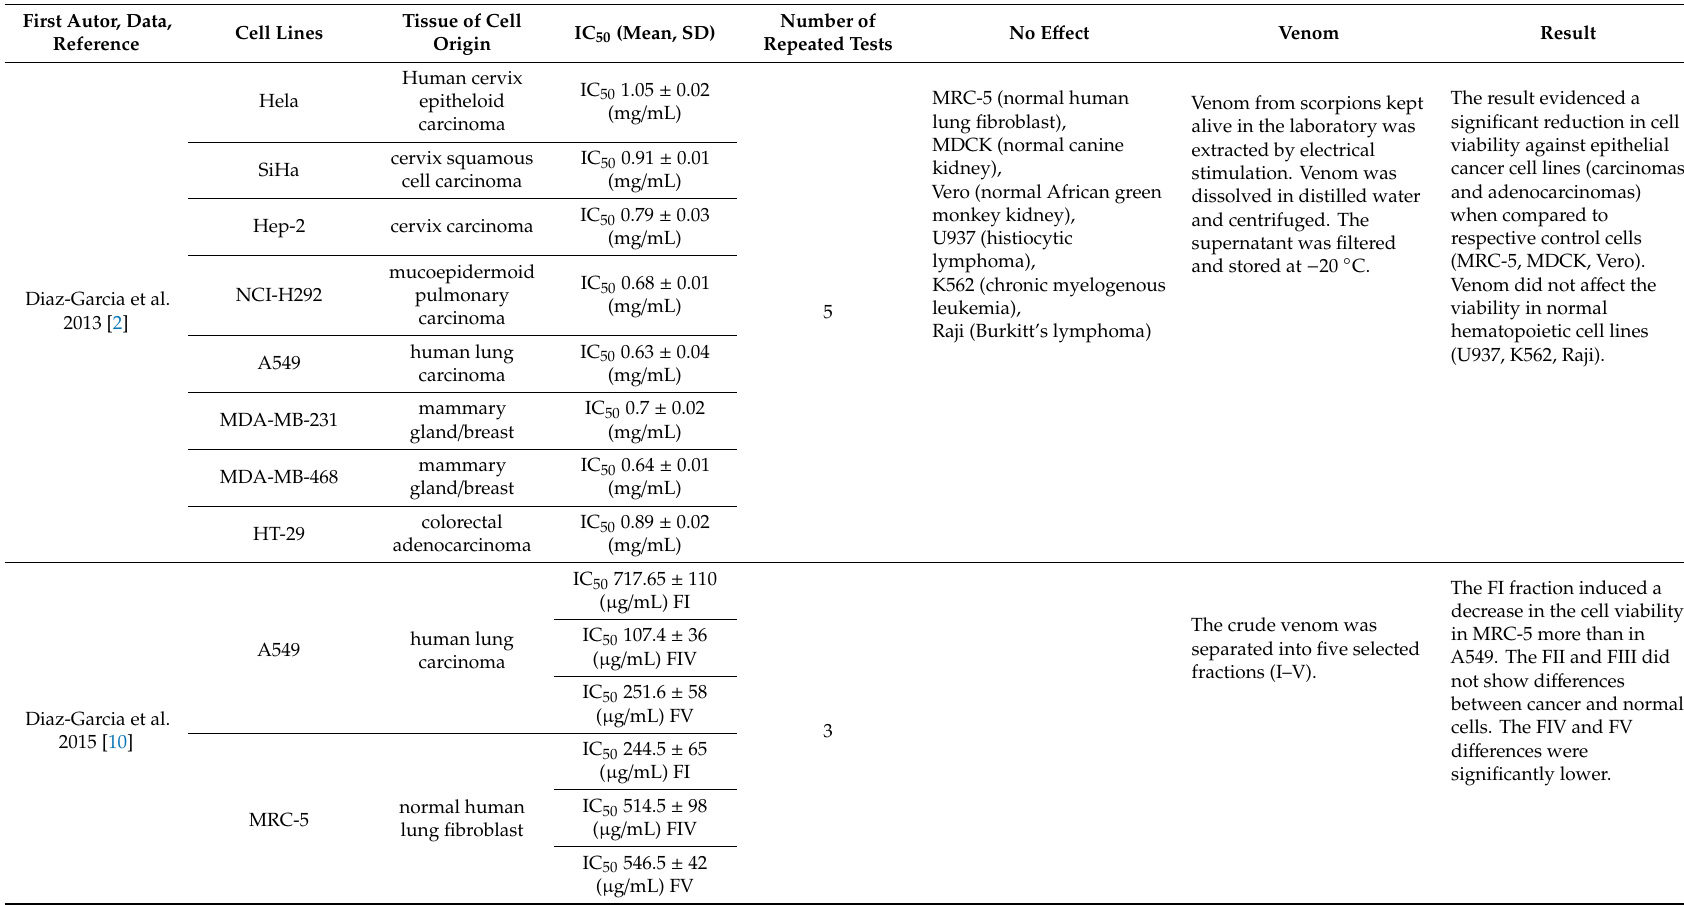
Table 2. The data extracted for the four articles included in the